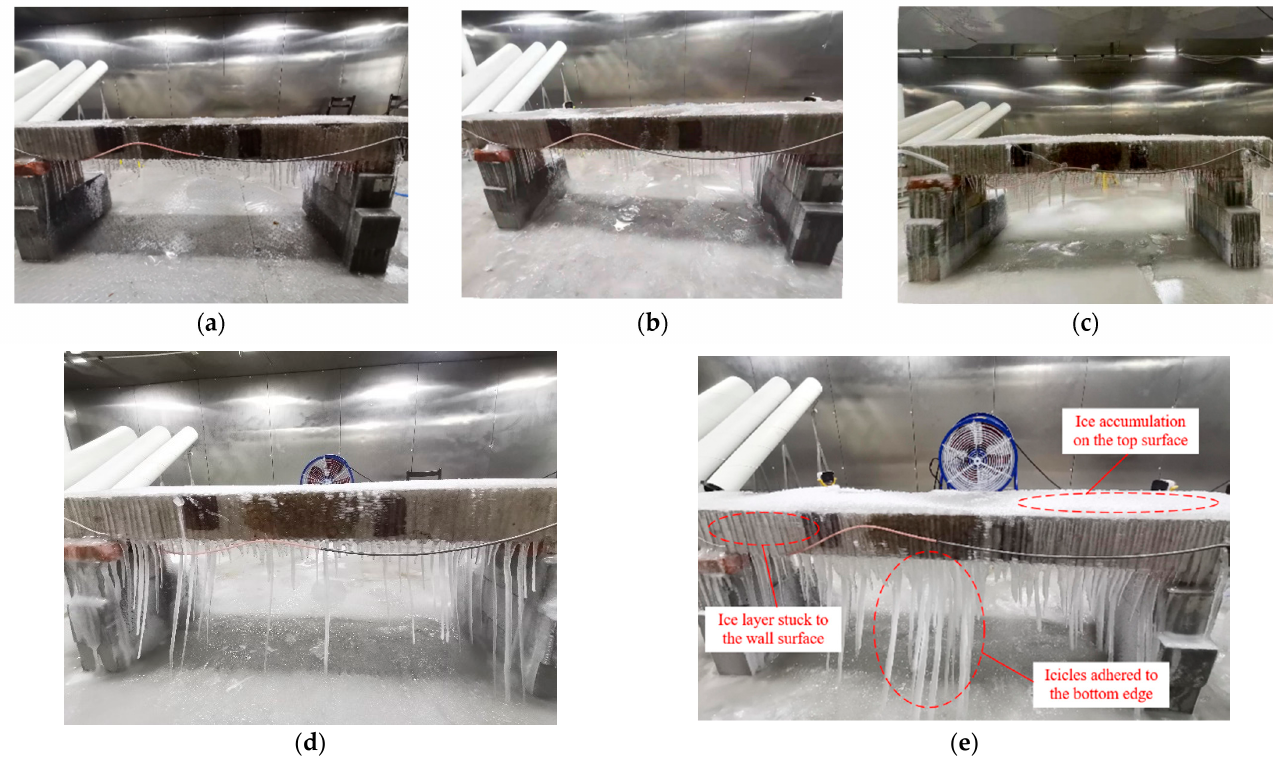
Figure 9. Icing diagram after 120 min of spraying: ( a ) − 5 °C, ( b ) − 10 °C, ( c ) − 15 °C, ( d ) − 15 °C and 3 m/s, ( e ) − 15 °C and 5 m/s.